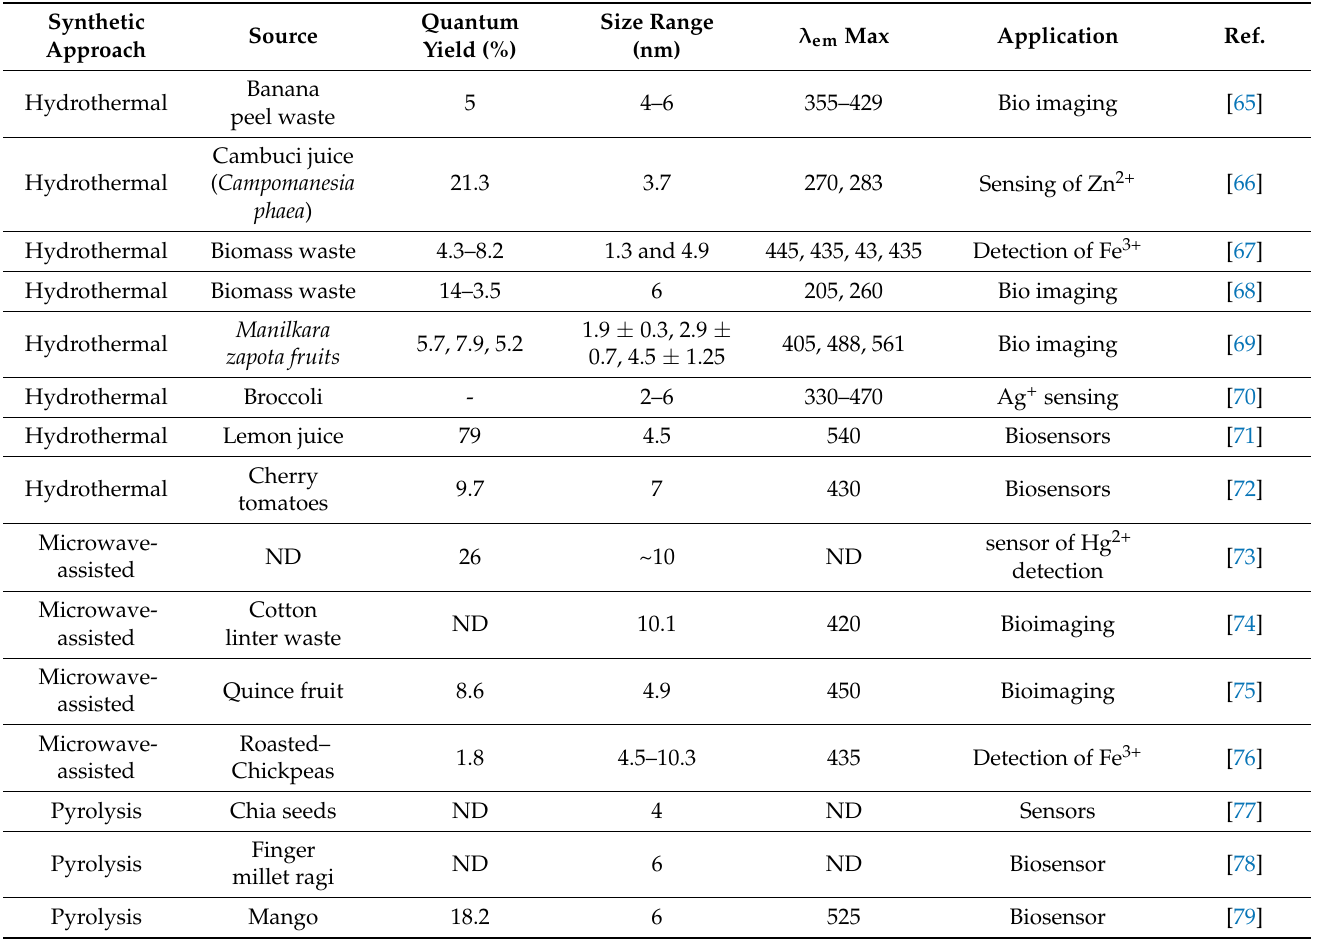
Table 1. Recent green quantum dots produced by the bottom-up approach (Hydrothermal, microwave-assisted, and pyrolysis) and their